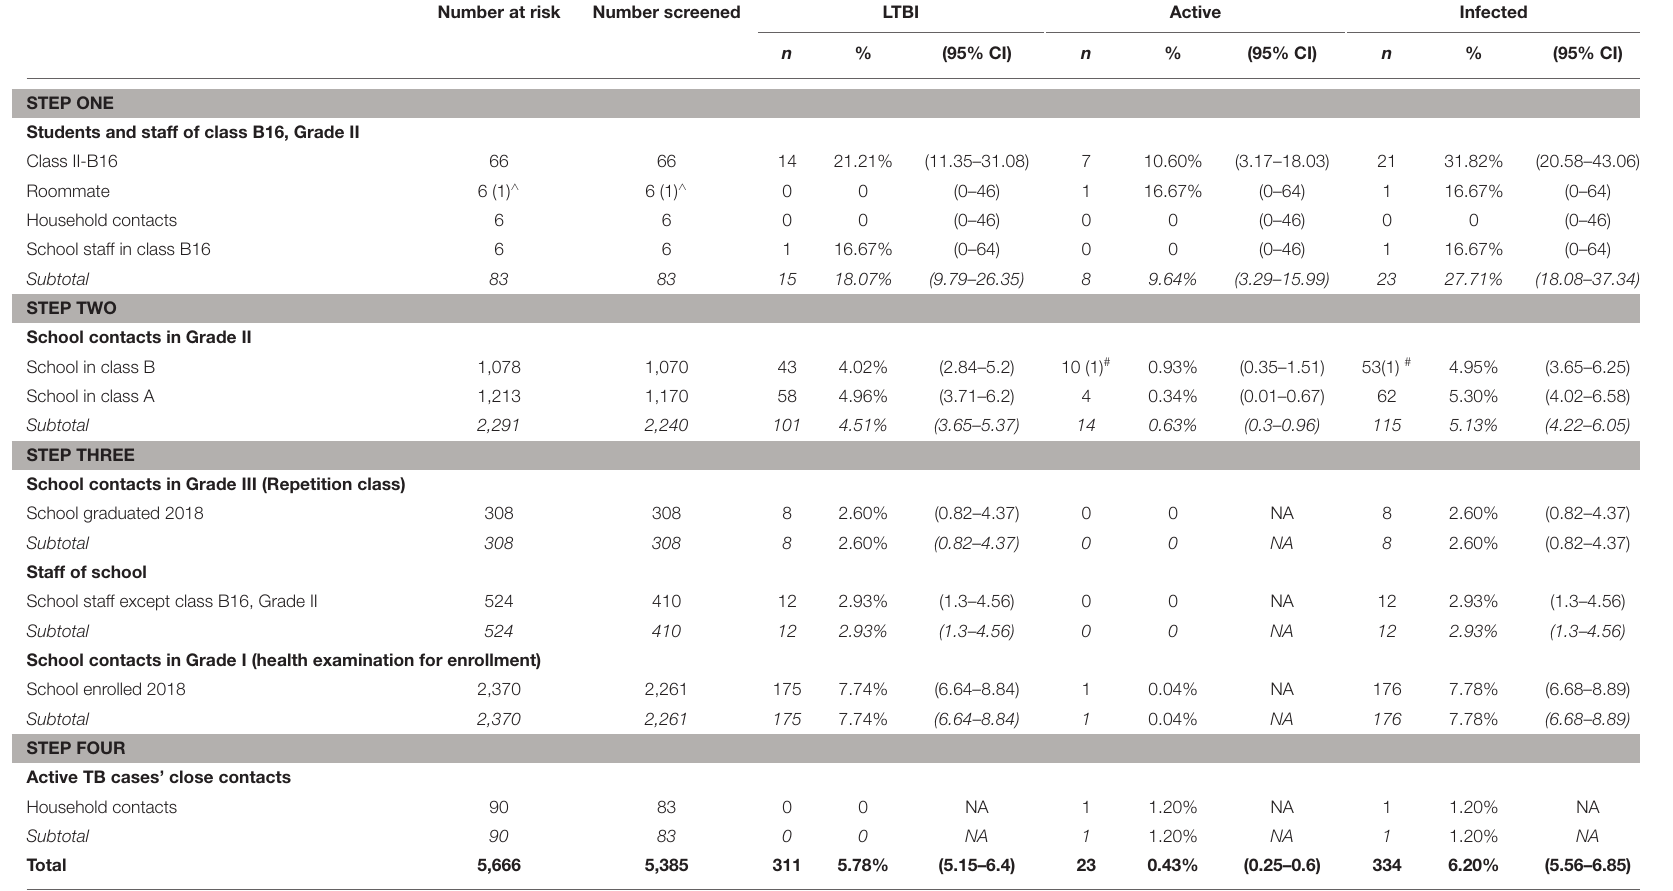
TABLE 1 | Primary case contact investigations during a school tuberculosis outbreak, Luoning, Henan, China